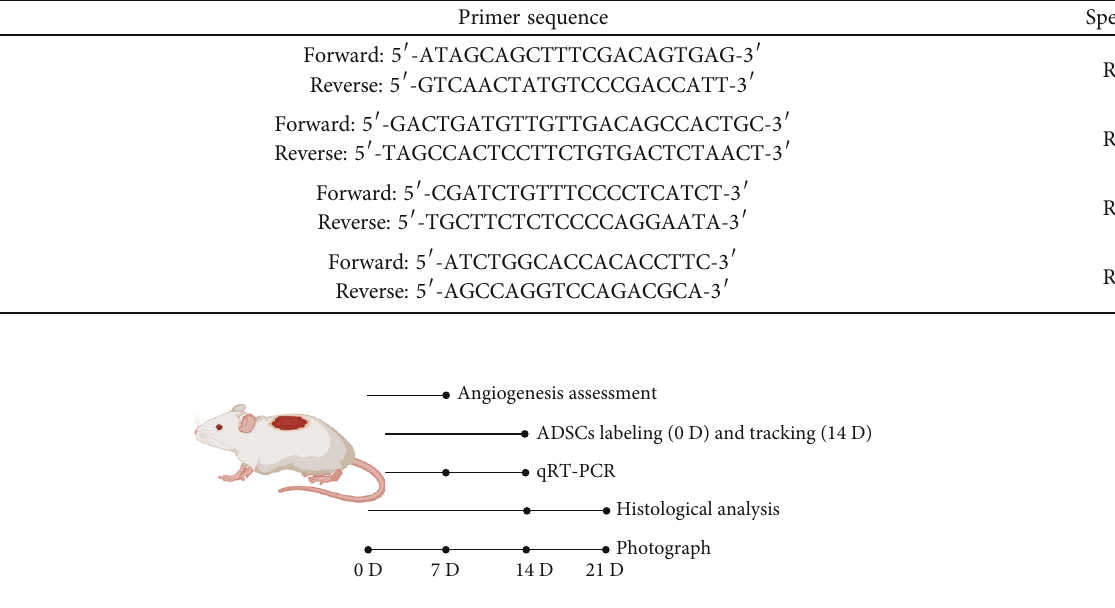
Table 1: Primer sequences used for qRT-PCR analysis.